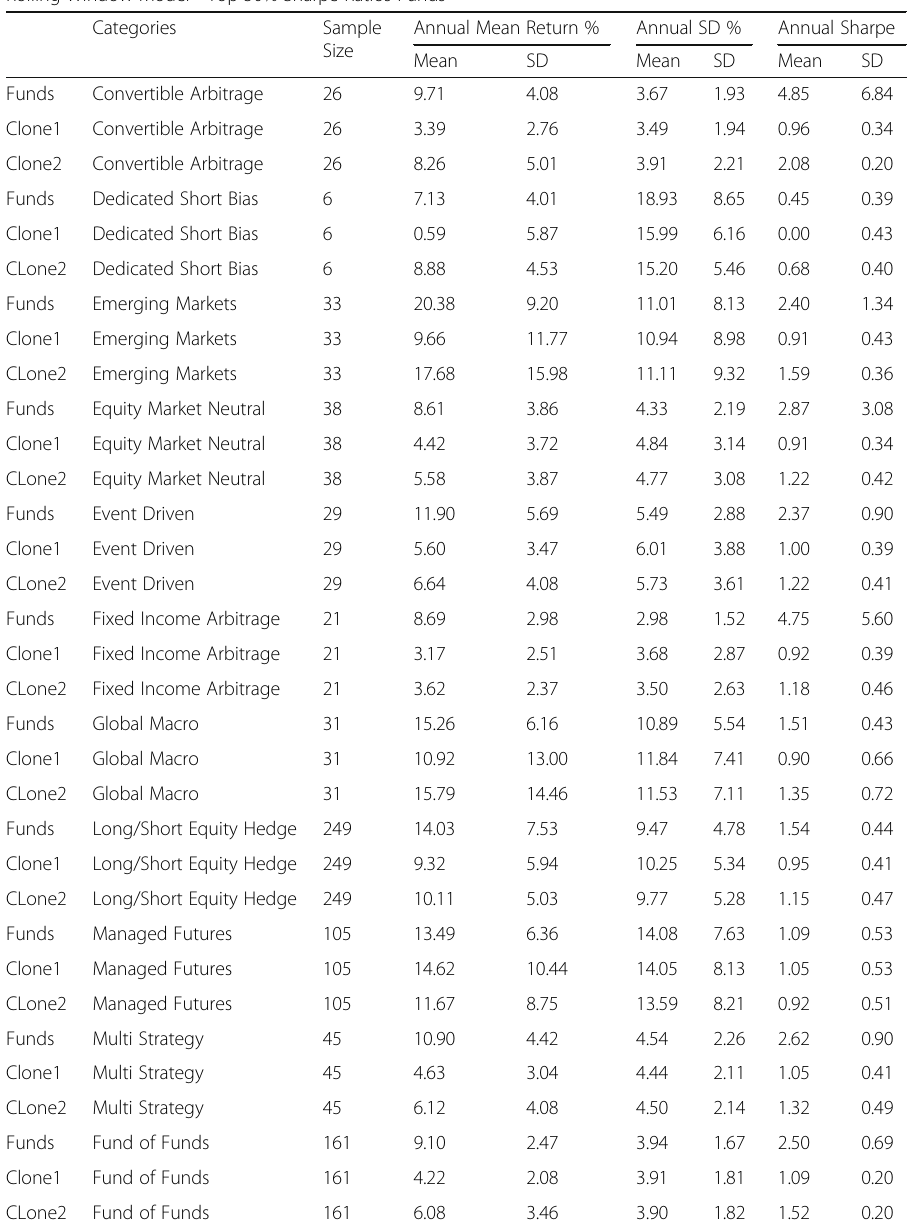
Table 4 Performance comparison for rolling window model for top 50% Sharpe ratio funds and their